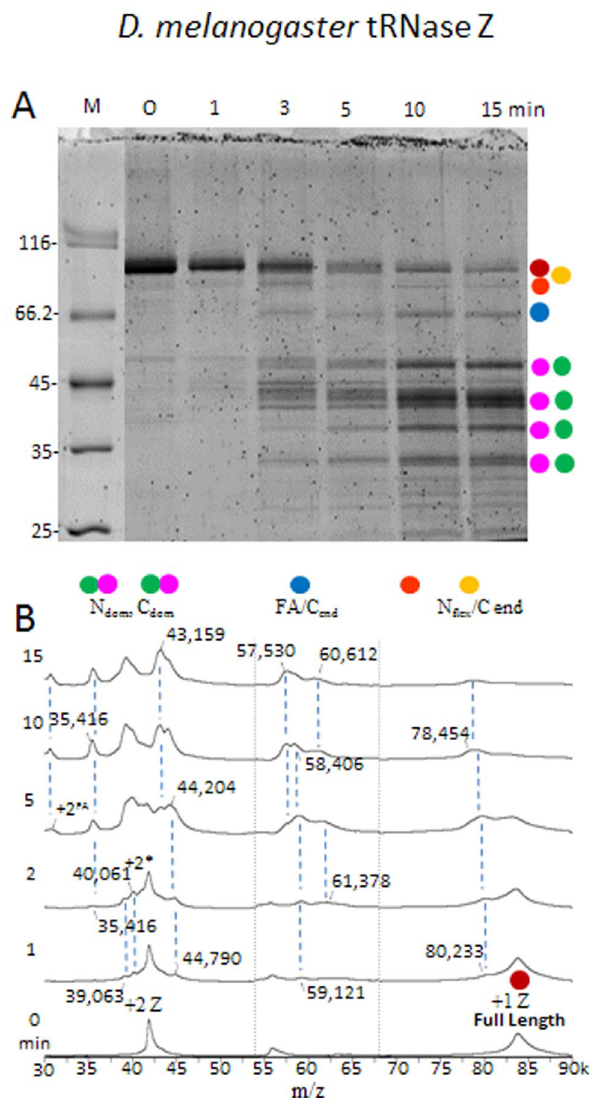
Figure 3. Trypsin digestion of purified tRNase Z followed by mass spectrometry shows the main stable domains and flexible regions. A) Protein gel lanes illustrate extent of digestion of D. melanogaster tRNase Z by trypsin. Colored dots (red, orange, blue, magenta and green) indicate full length tRNase Z and the tryptic fragments arising from cleavage at N flex , FA, N dom -tether and C end . B) Spectra obtained by mass spectrometry of the samples illustrated in (A). MALDI-TOF was performed using a Waters MaldiMX. Representative masses are presented on the spectra and the complete table (mass observed, mass calculated, ppm error and theoretical pI) is presented in Supplementary Table ST1.